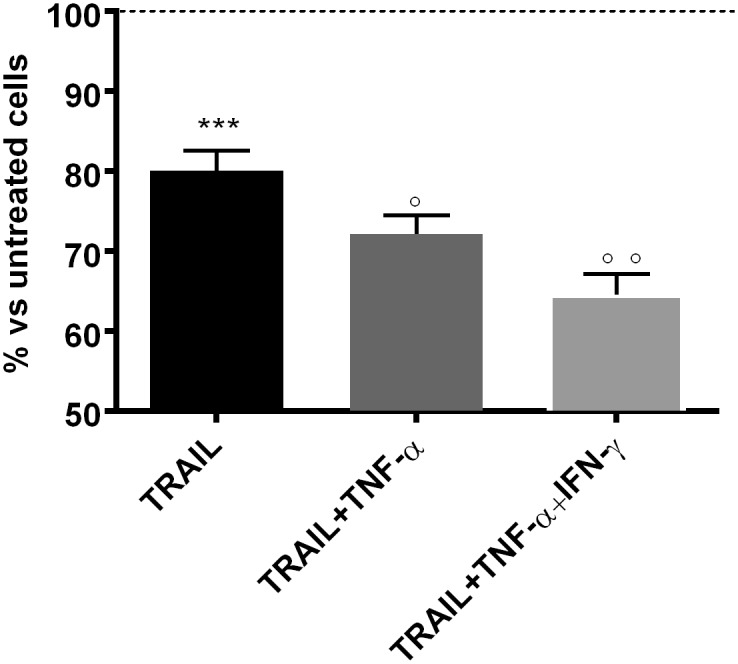
TNF-α-induced hUC-MSC death amplified by TRAIL.hUC-MSCs of two different clones (Clones 63 and 69, 2x104 in 96-well plates) were stimulated with TRAIL (500 ng/ml, 28 nM) alone or in association with TNF-α (20 ng/ml, 1.2 nM) and IFN-γ (50 ng/ml, 3 nM) for 48h. Then, cell death was scored by CellTiter-Glo Luminescent Cell Viability Assay. Data from the two clones were pooled (mean±SEM of six ATP measurements; *** p<0.0001 when compared with untreated cells; °p<0.05, °°p<0.01 when compared with TRAIL alone-treated cells). Representative of 3 different experiments.